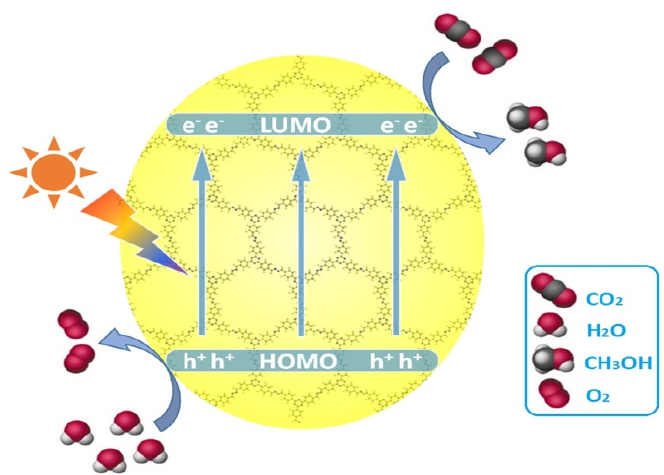
Figure 9. Schematic diagram for the photocatalytic reduction of CO 2 over azine-based COFs upon visible light irradiation. Copied with permission from Elsevier 2018 [38].